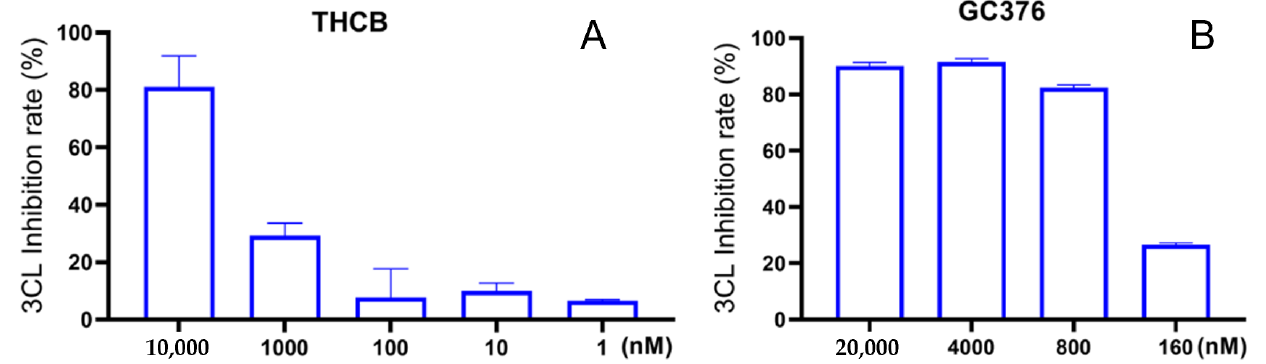
Figure 11. The concentration-dependent anti-M pro activity of THCB ( A ) and the positive control GC376 ( B ) measured by a biochemical assay.